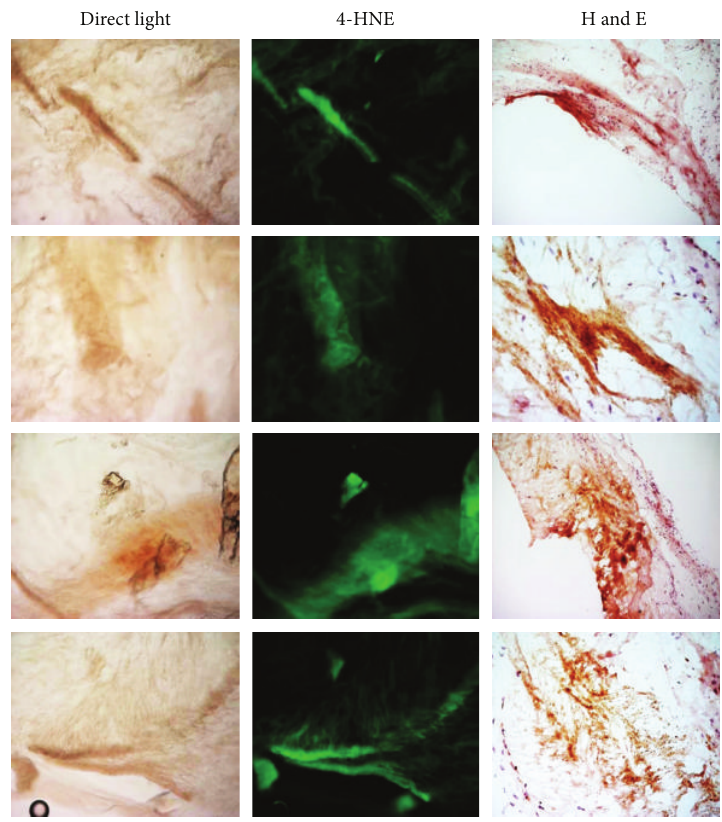
Figure 7: Immunoreactivity for 4-HNE in AKU aortic valve leaflet. The presence of 4-HNE in the AKU valve was uniformly diffused and the distribution of 4-HNE-positive area was perfectly superimposing to ochronotic pigmented areas. The presence of lipid peroxidation and ochronotic pigment was found to be strictly related to areas of lymphocytes accumulation. Magnification 20x.